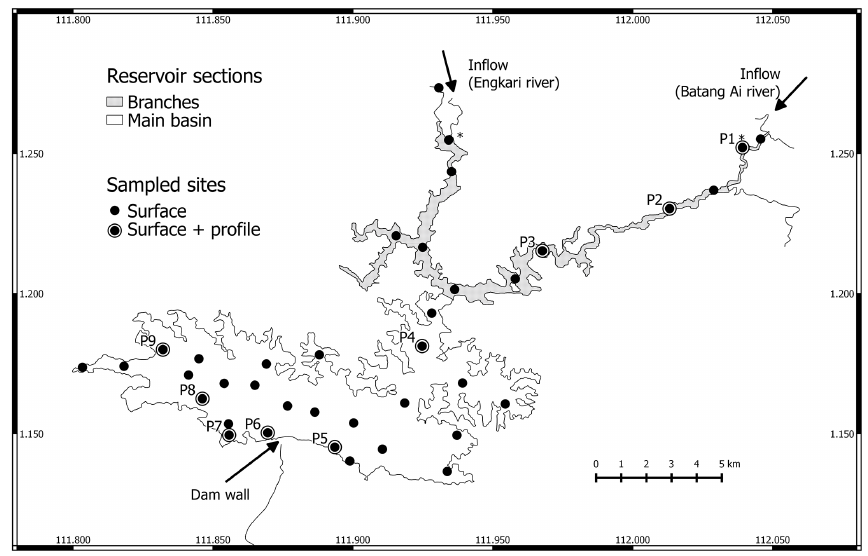
Figure 1. Map of Batang Ai reservoir with delimited sections (branches and main basin) and sampling points. ∗ Represents sampling points at the branches’